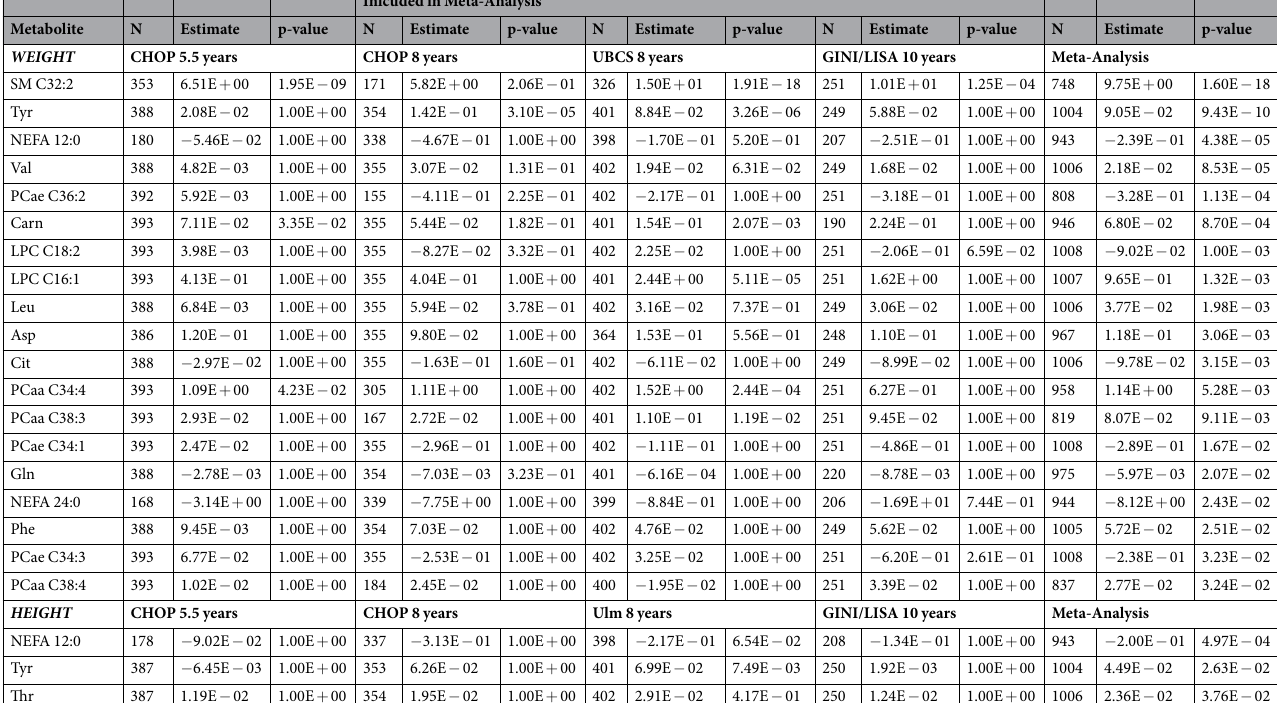
Table 3. Significant associations of metabolites with weight and height in the meta-analysis and the corresponding results from the linear regression models in each study/follow-up. Results are from multivariate linear models regressing the weight and height on the metabolite, adjusted for sex and age. The meta-analysis is based on the CHOP 8 years, UBCS and GINIplus/LISA infants. P-values were Bonferroni